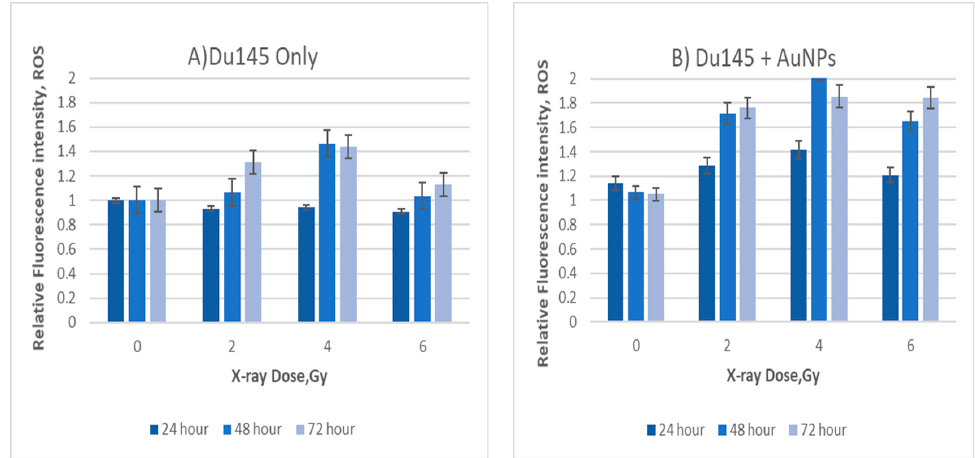
Figure 5. Relative mitochondrial ROS levels in DU145 cells after irradiation ( A ) without AuNPs and ( B ) with AuNPs. Cells were exposed to doses from 0 to 6 Gy. Data are represented as mean values ± SD of three replicate samples.